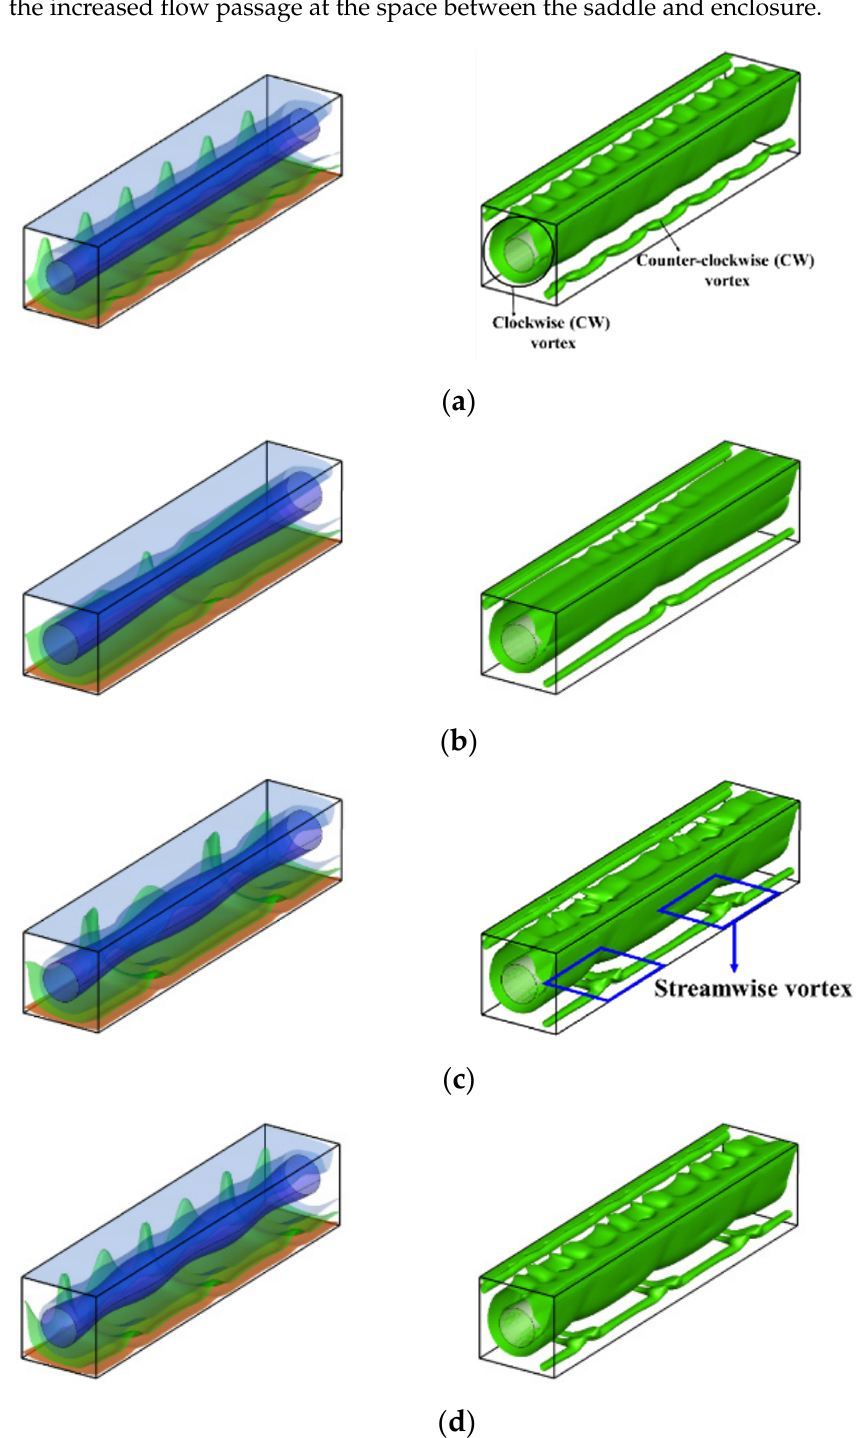
Figure 5. Distribution of temperature with θ = 0.1, 0.5, and 0.9 and vortical structure with λ 2 = − 0.1